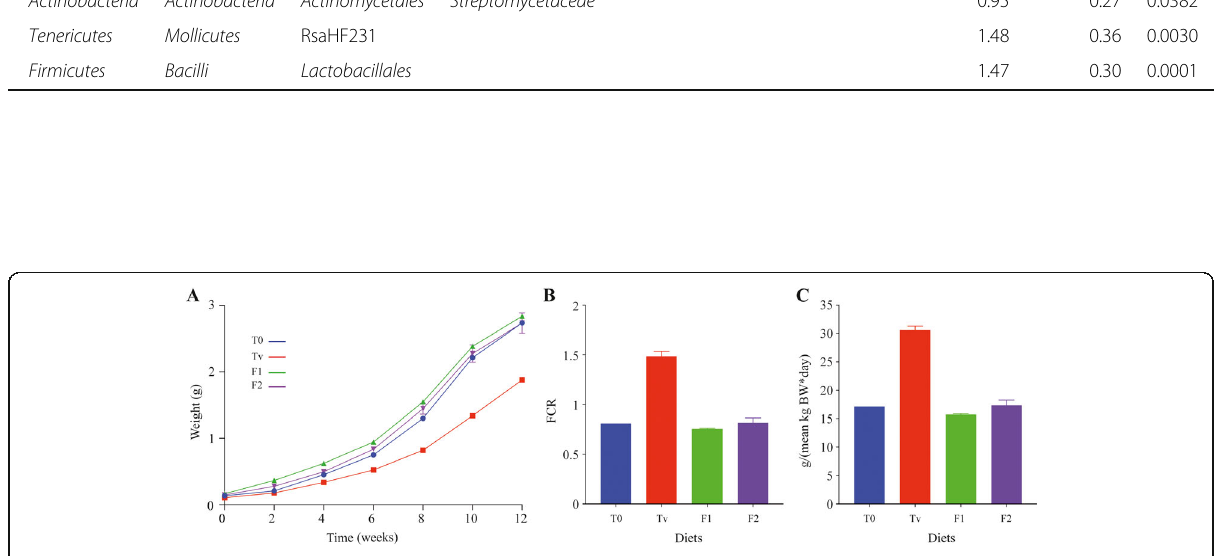
Fig. 5 Body weight gain, Feed Conversion Ratio (FCR) and daily feed intake. A Evolution of body weight gain of rainbow trout fed with different experimental diets from the first feeding and during 12 weeks . Mean body weights for each diet are presented as mean ± standard error. B Feed Conversion Ratio (FCR) were calculated per tank as follows: FCR = feed intake (g)/ fish weight gain (g) during the 12 weeks. C Daily feed intake was calculated for each tank as follows: feed consumed (g) / mean kg body weight.day. Mean values for each diet are presented as mean ± standard error. T 0 : commercial fishmeal-rich diet ( n = 1); Tv: full terrestrial plant-based diet devoid of fishmeal ( n = 2); F1: plant-based diet in which 11% of plant proteins have been replaced by 5.5% of proteins from yeast (YEA) and 5.5% of proteins from insect larvae (INS) ( n = 2); F2: plant- based diet in which 16.5% of plant proteins have been replaced by 5.5% YEA, 5.5% INS and 5.5% processed animal proteins (PAP) ( n =